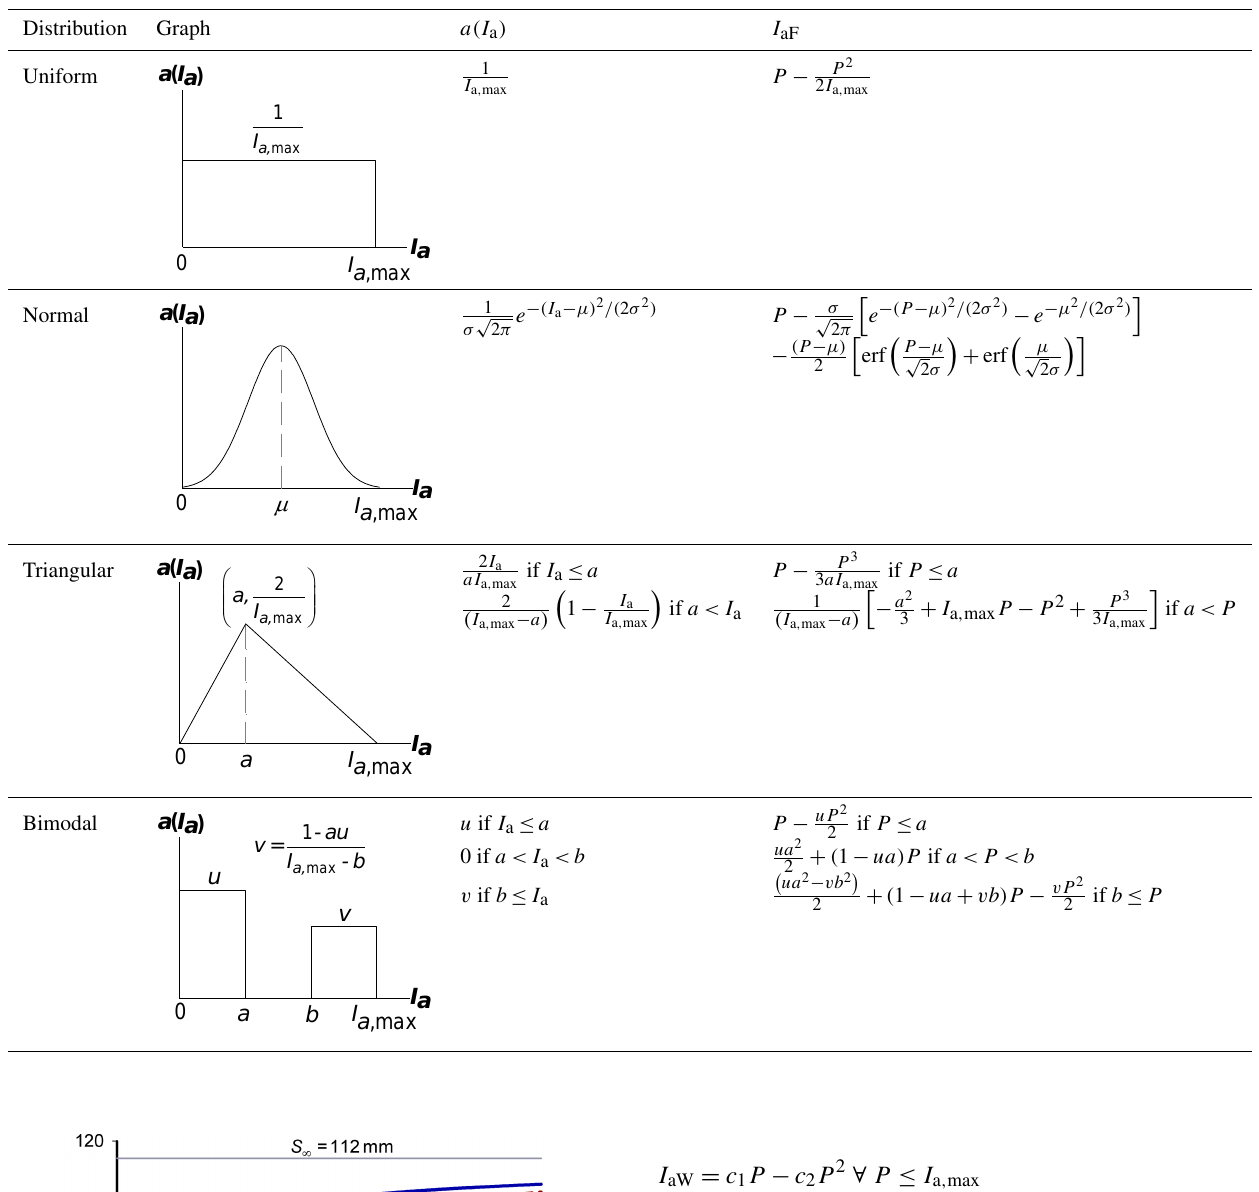
Table 1. Functional forms of a(I a ) and I aF for various synthetic distributions. Distribution Graph a(I a ) I aF Uniform